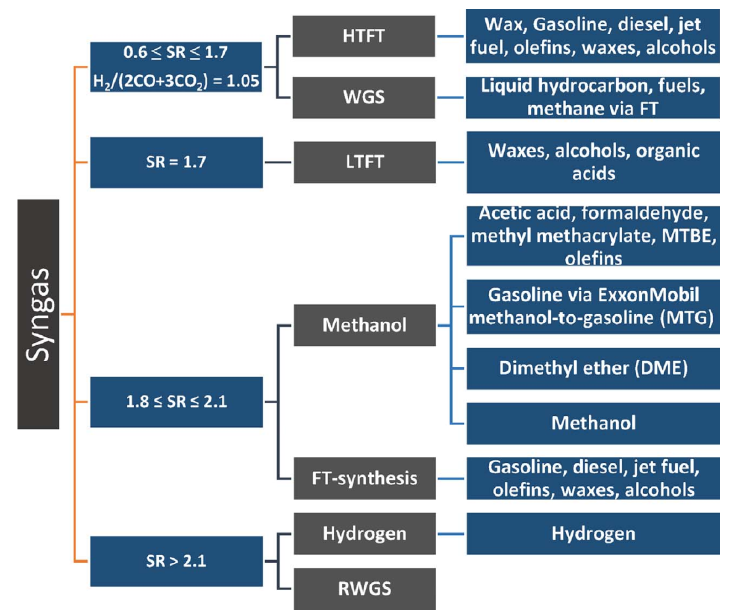
Figure 21. Products that can be obtained from syngas. SR: steam reforming; HTFT: high-temperature Fischer–Tropsch synthesis; LTFT: low-temperature Fischer–Tropsch synthesis; WGS: water gas shift reaction; RWGS: reverse water gas shift; FT: Fischer–Tropsch. Reproduced with permission from Priyadarshini Balasubramanian, Ishan Bajaj, M.M. Faruque Hasan, Journal of CO 2 Utilization; published by Elsevier, 2018 [410].